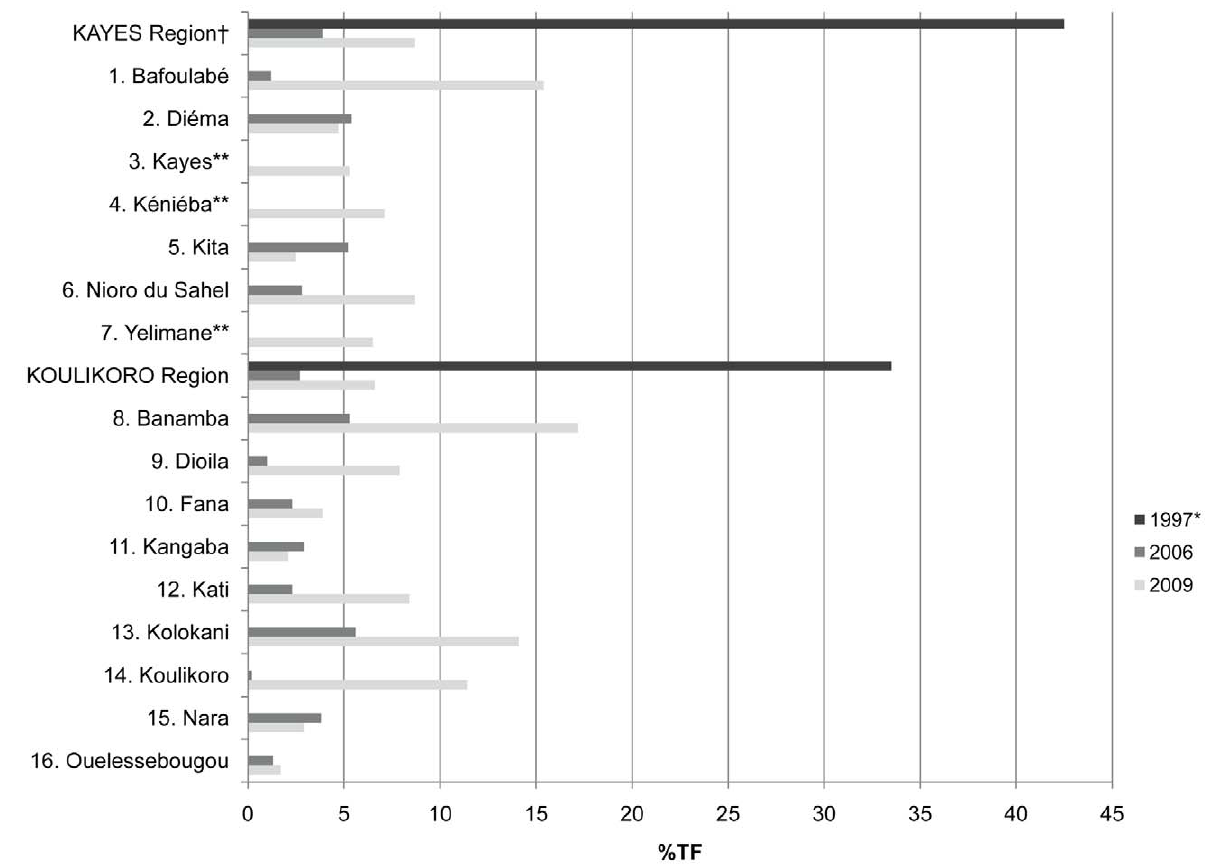
Figure 3. Prevalence of TF among children less than 10 years of age in Kayes and Koulikoro, Mali 1997*, 2006 and 2009. { estimate based on surveyed districts. *regional estimate from Sche´mann et al 1998. **districts not surveyed in 2006.